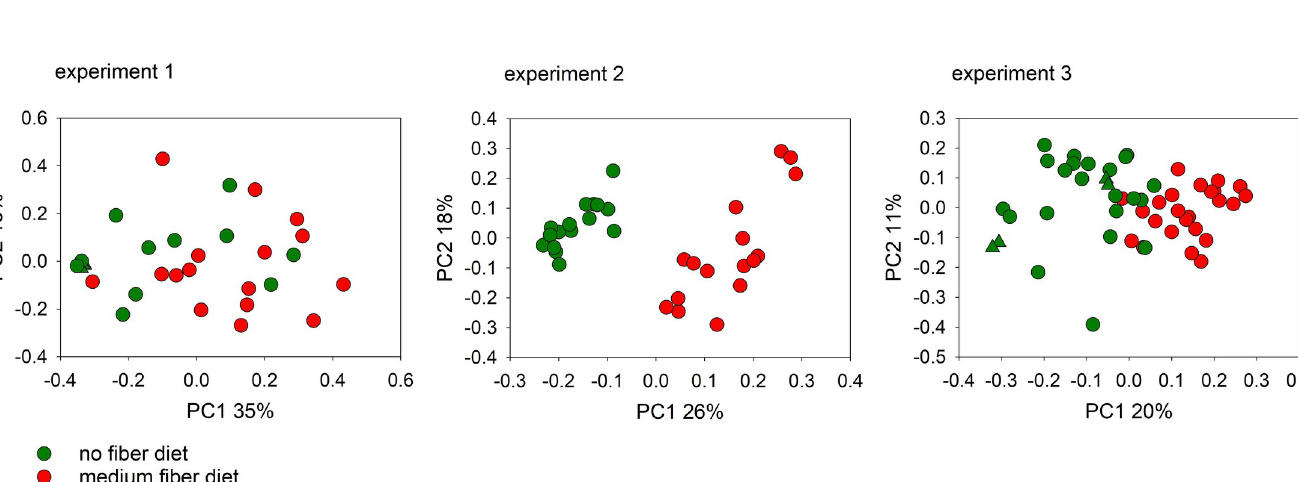
Fig 3. Impact of diet on the fecal microbiome of mice infected with C . parvum (experiment 1) and C . tyzzeri (experiment 2/3). Principal Coordinate Analysis was used to display weighted UniFrac distances between pairs of fecal microbiota. Experiment 1 analysis includes data from 31 fecal samples collected from individual mice starting on day 5 of treatment (day 0 PI) until day 21 of treatment (day 16 PI). For experiment 2/3, 32 and 50 samples, respectively, from individual mice were analyzed. Each data point represents one fecal sample, color-coded according to treatment. Matching triangle symbols indicate replicate analyses of the same fecal samples. The distance between replicates is a measure of technical